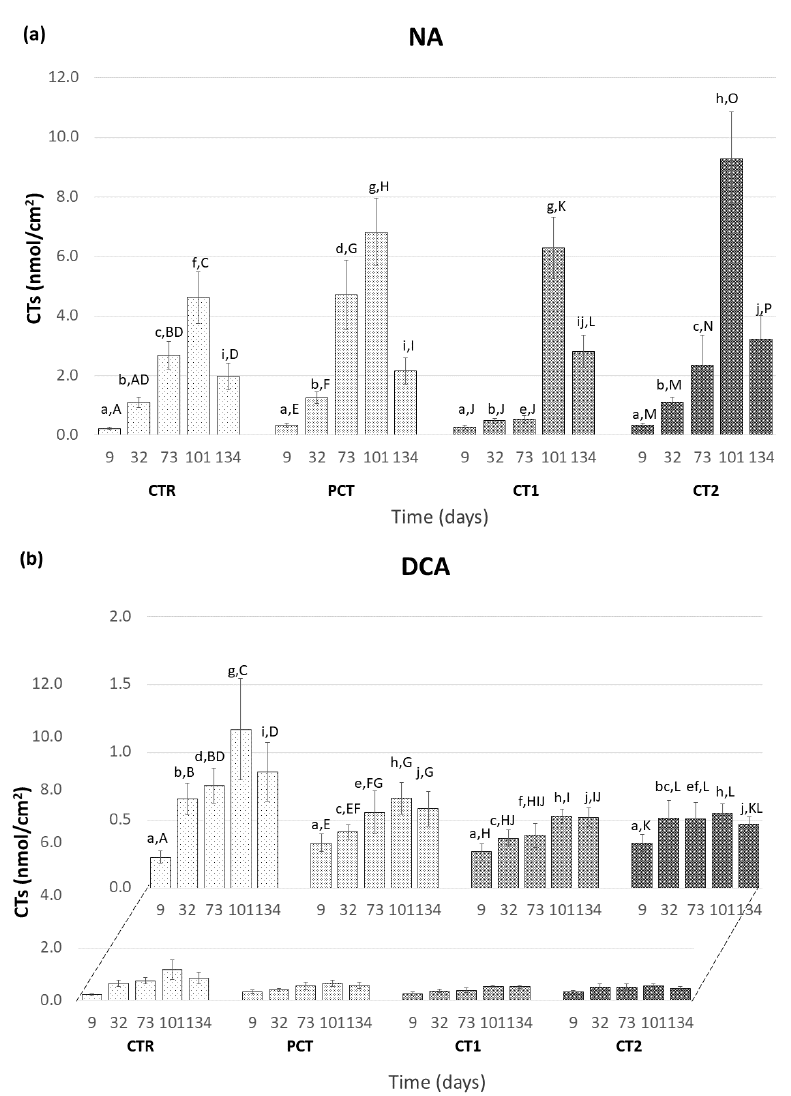
Figure 6. Evolution of conjugated trienols (CTs) content in the peel of “Rocha” pear. ( a ) NA (normal atmosphere); ( b ) DCA (dynamic controlled atmosphere) storage conditions. For each atmospheric storage, four coating conditions are presented as follows: CTR (control), PCT (pectin), CT1 (coating 1), and CT2 (coating 2). Values are mean ± SD of five replicates. The values followed by the same lowercase letter indicate no significant di ff erences at the same sampling time between storage conditions, and by the same uppercase letter indicate no significant di ff erences between sampling times within each coating condition (LSD test at p <